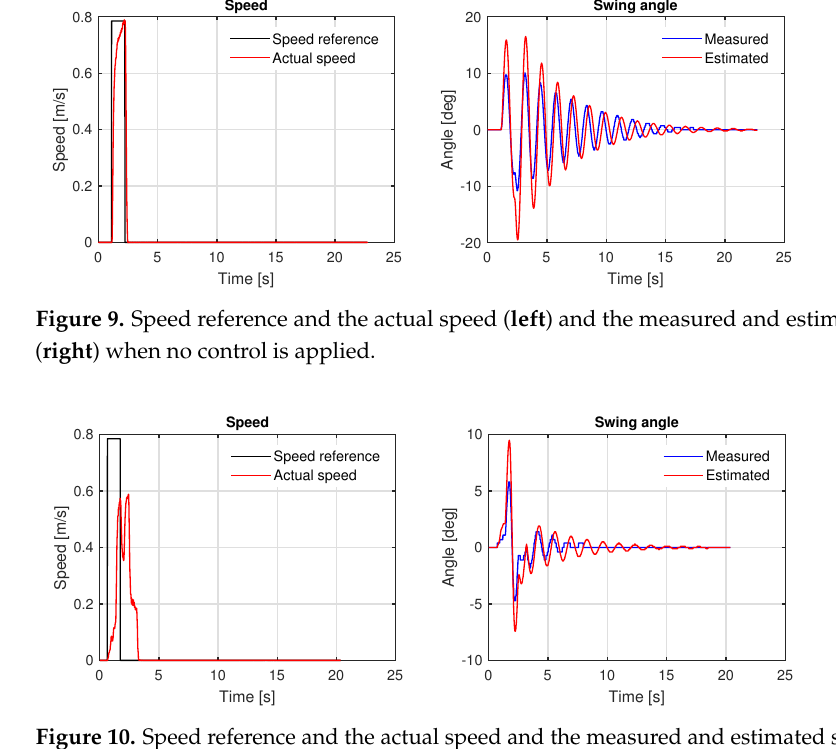
Figure 10. Speed reference and the actual speed and the measured and estimated swing angles when the EI shaper is